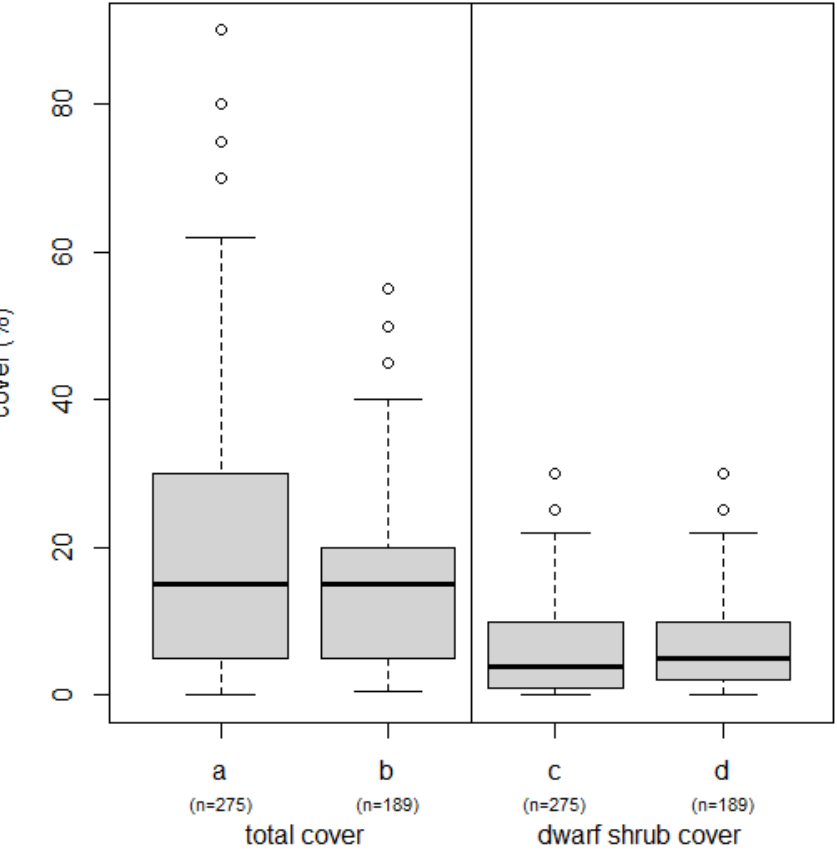
Figure 2. Boxplots of total vegetative ground cover for all vegetation plots ( a ) and vegetation plots with the presence of A. leucotricha and/or K. ceratoides ( b ). Dwarf shrub ground cover for all vegetation plots ( c ) and vegetation plots with the presence of A. leucotricha and/or K. ceratoides ( d